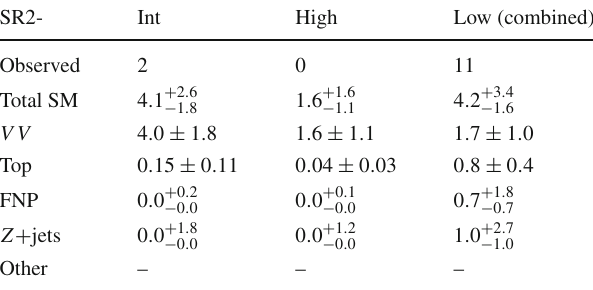
results for the inclusive signal regions in the 2 (cid:4) + 0 jets channel. All systematic and statistical uncertainties are included in the fit. The “other” backgrounds include all processes producing a Higgs boson, V V V and t ¯ tV . A “–” symbol indicates that the background contribution is negligible